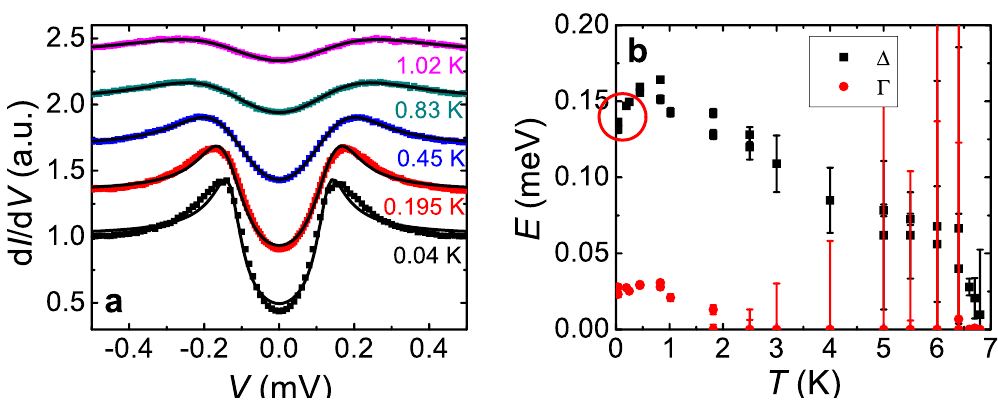
Figure 4. Fittings to point contact spectra of a NbSe 2 /16 QL Bi 2 Se 3 heterostructure at low temperatures. ( a ) Normalized conductance spectra of a point contact on a NbSe 2 /16 QL Bi 2 Se 3 sample at low temperatures. Curves are shifted vertically for clarity. The black lines are BTK model fits to the experimental data. ( b ) The temperature dependence of the superconducting energy gap Δ and broadening parameter Γ values from the BTK model fittings in Fig. 4a.